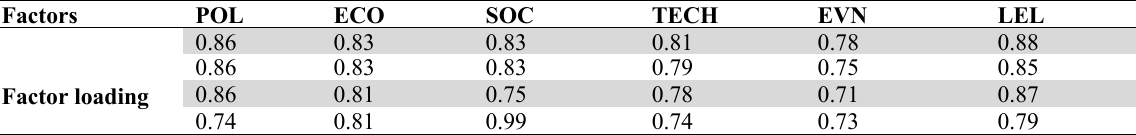
Validity result Factors